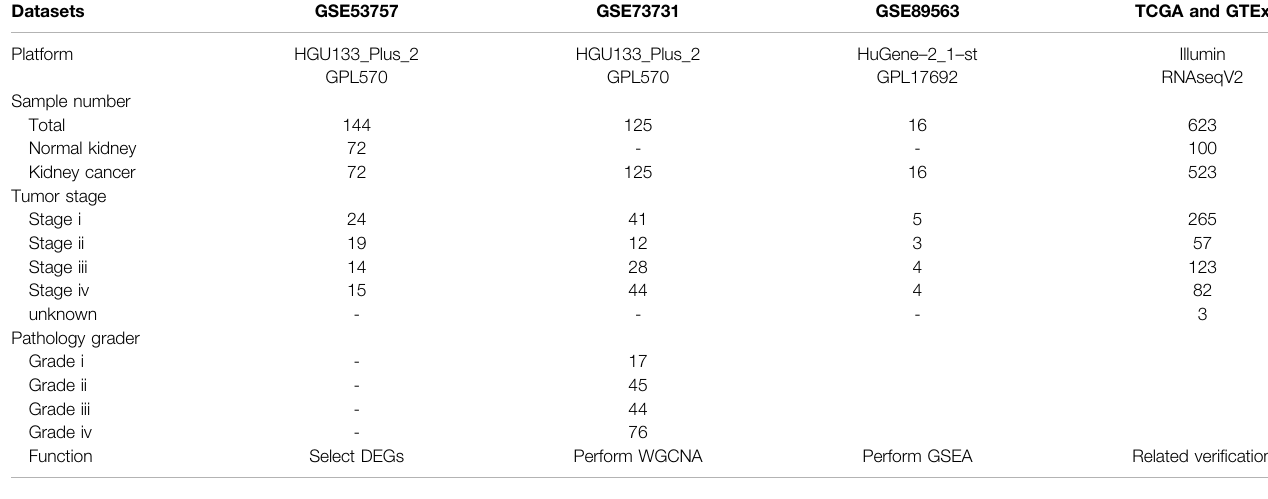
TABLE 1 | Detailed information about datasets.